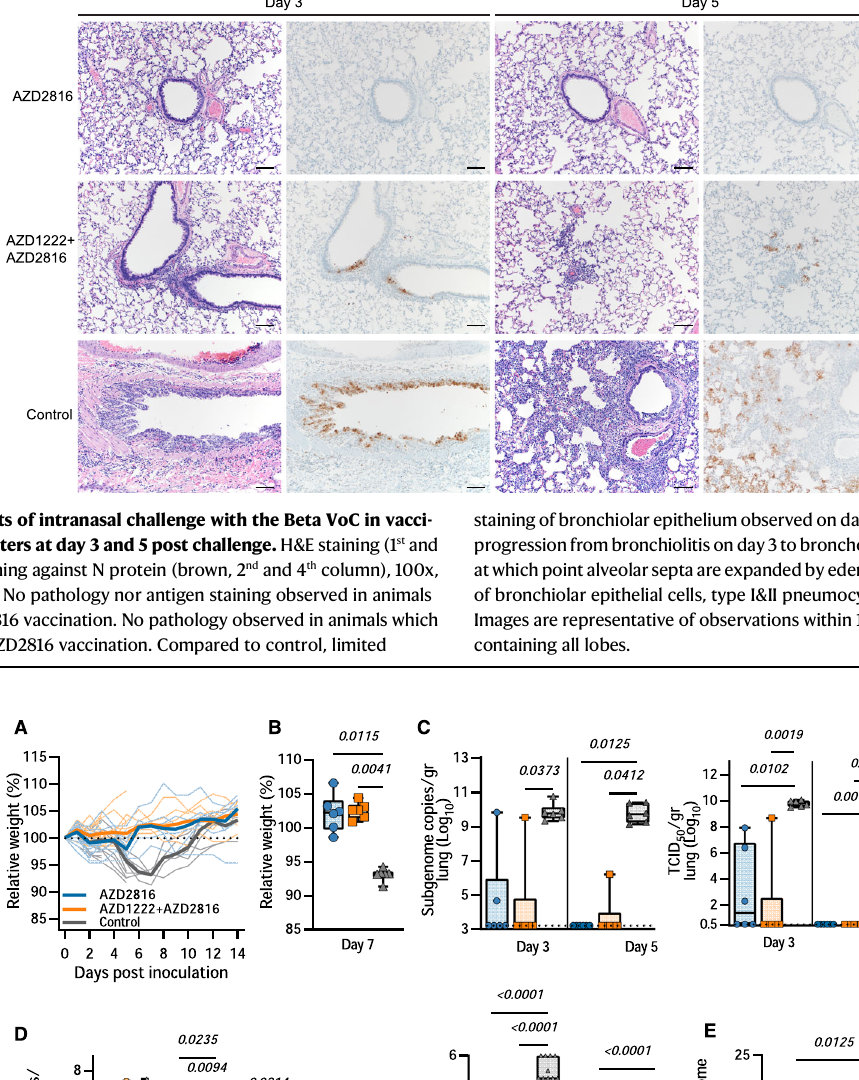
oropharyngealswabstakenonday1(sgRNAonly, N =18),3( N =18),5( N =12),and7 (sgRNA only, N =6). Statistical signi fi cance was determined via a mixed-effects analysis followed by Dunnett ’ s multiple comparisons test, comparing vaccinated groupsagainstcontrolgroup.Dottedline=limitofdetection. E Boxplot(minimum to maximum) of the AUC analysis of shedding as measured by sgRNA analysis in swabs collected on 1 – 7days post-inoculation. Statistical signi fi cance was deter- mined via a Kruskall-Wallis test followed by Dunn ’ s multiple comparisons test. N =6, circles=hamsters vaccinated with AZD2816, squares=hamsters vaccinated withAZD1222followedbyAZD2816,triangles=hamstersvaccinatedwithChAdOx1 GFP. All boxplots are drawn from fi rst quartile to third quartile, with a line at the median. Whiskers go from each quartile to minimum or maximum values. Source data are provided as a Source Data fi le.